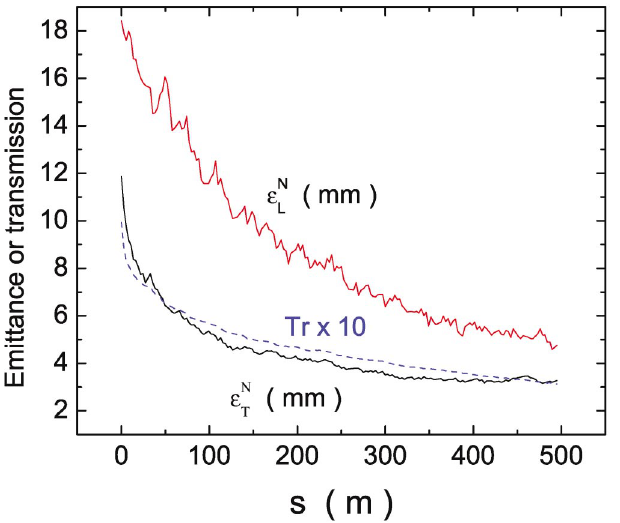
FIG. 15. (Color) Normalized emittances and transmission with decay included as a function of accumulated distance in the realistic cooling ring. One turn is 33 m.